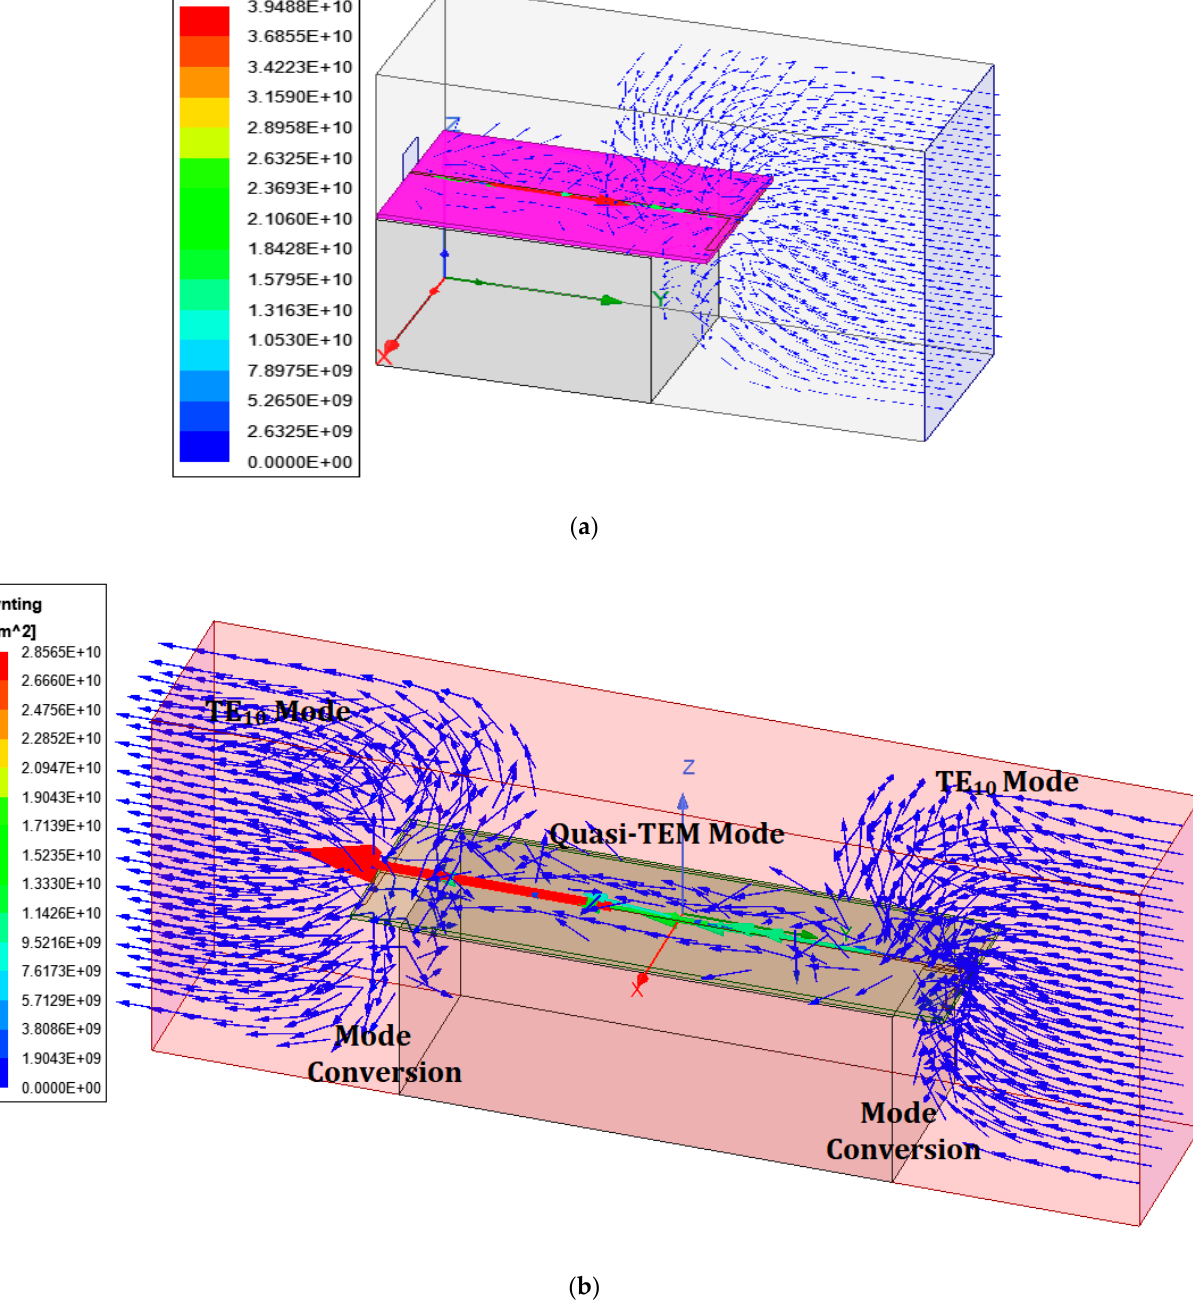
Figure 8. Power flow in the transition: ( a ) conventional transition and ( b ) back-to-back transition. When two conventional transitions are connected by 180° out of phase, a back-to-back microstrip line to rectangular waveguide transition is formed. In this, the exchange of energy is between the two waveguide ports. The RF power applied at one waveguide port by exciting the dominant TE 10 mode is converted to the quasi-TEM mode at the mi- crostrip interface, and then the quasi-TEM mode of the microstrip line is converted back into the TE 10 mode at the MS line-to-RWG interface and then received at WG port-2, as represented in Figure 8b.